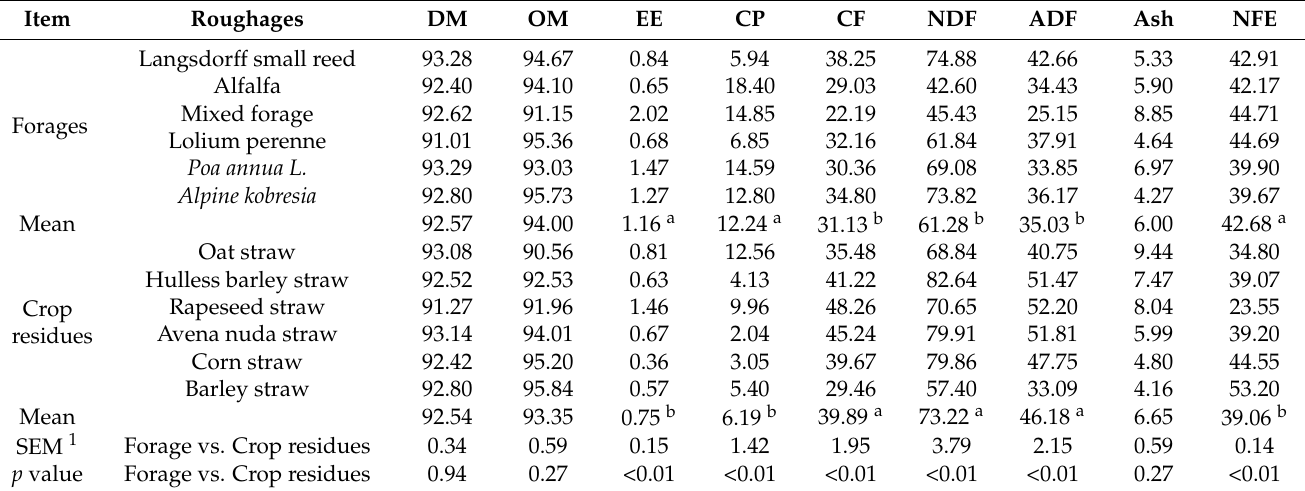
Table 1. Chemical compositions of roughages (DM basis, expressed as %).